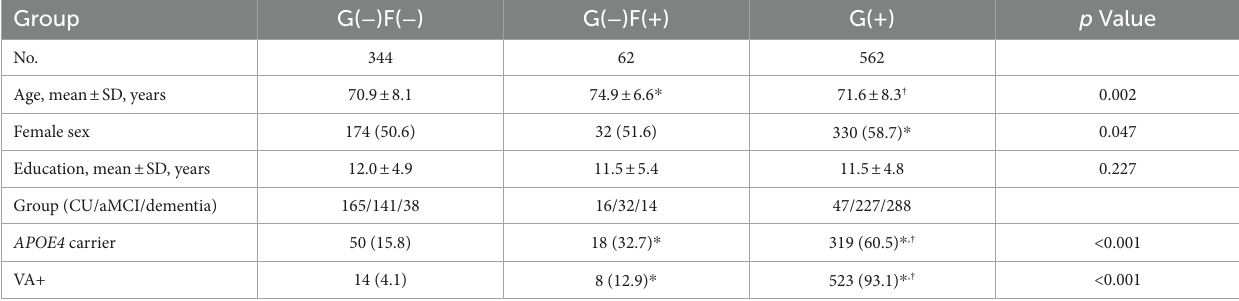
TABLE 2 Demographics of the study participants by